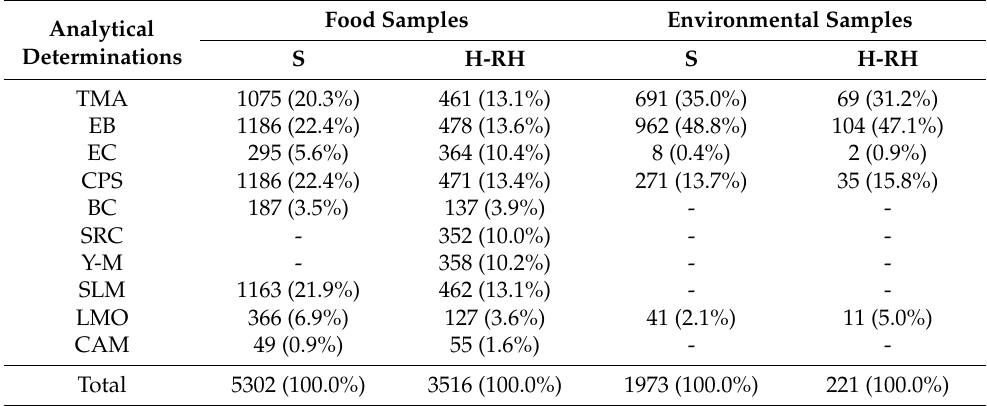
Table 4. Analytical determinations performed on food and environmental samples for schools (S) and hospitals/retirement homes (H-RH).